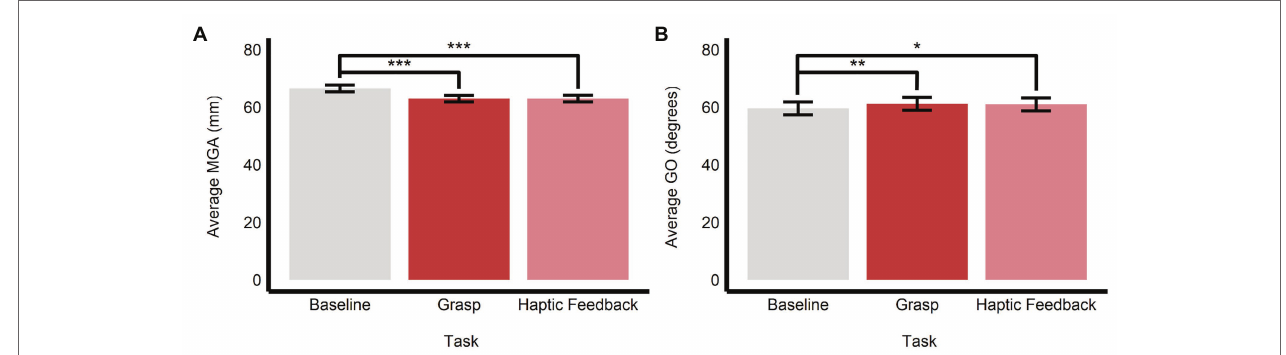
FIGURE 7 | Effects of obstacle avoidance and prior perceptual processing on grasping movements. Estimated marginal means of (A) maximum grip aperture and (B) grip orientation are plotted for the three different kinds of grasping tasks employed in this study. Comparing the baseline and grasp tasks reveals the effects of obstacle avoidance, whereas comparing the grasp and haptic feedback tasks reveals the effects of prior perceptual processing on subsequent grasping movements. * p < 0.05, ** p < 0.005, *** p < 0.0001; error bars depict SEM; MGA, maximum grip aperture; GO, grip